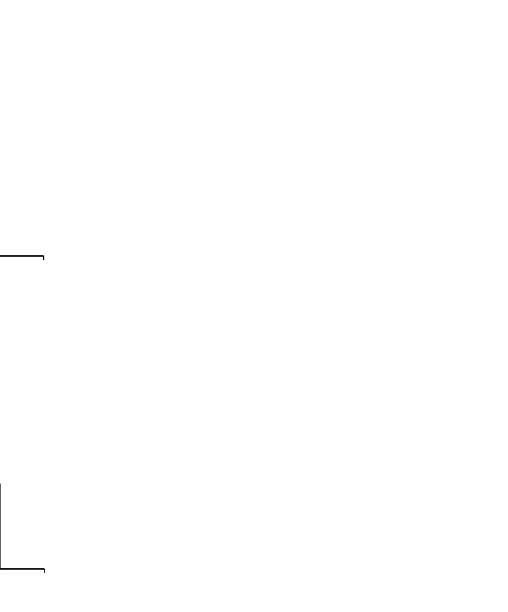
Figure 2. Mean (± SD) plasma ( a ) 17 ‐β estradiol (E 2 ) (femalesand ( b ) 11 ‐ Ketotestosterone (11 ‐ KT) (males) concentrations in meagre reared in floating sea cages. Different letters indicate statistically significant differences between consecutive periods (ANOVA; p < 0.05).